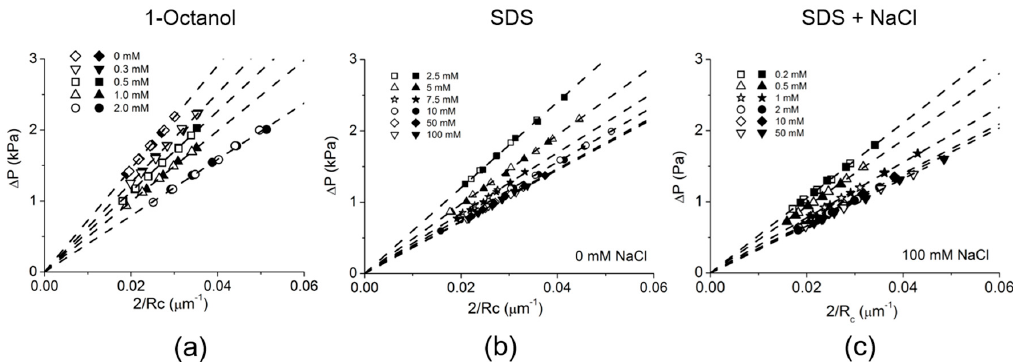
Figure 12. Equilibrium surface tension measurements for soluble surfactants. Pipette pressure vs. 2/ R c plots for test surfactants Octanol and SDS to give equilibrium surface tension of soluble monolayers at each of the test concentrations in aqueous solution for ( a ) 1-Octanol, ( b ) SDS and ( c ) SDS with 100 mM NaCl. Measurements were made for both increasing and decreasing applied pressure at 20 ◦ C. Hollow and solid symbols show the direction of applied pressure—hollow symbols: pressure increasing, interfacial area decreasing; and solid symbols: pressure decreasing, interfacial area increasing. Each surface tension was calculated from fitting slope as mentioned in the text corresponding to the plots in Figure 7c. Reproduced from Kinoshita et al. [7,8], with permission from Elsevier.